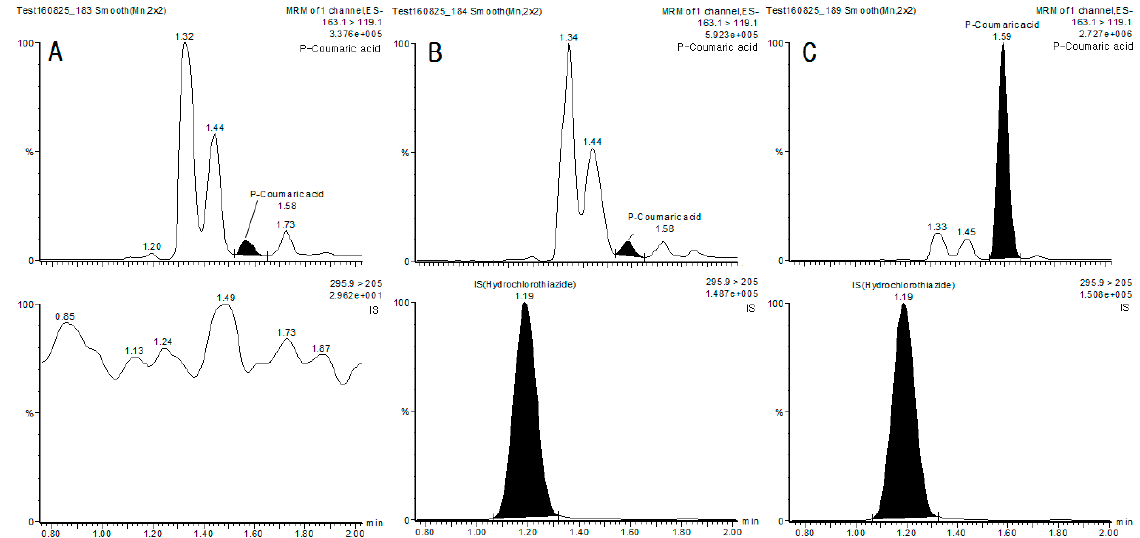
Figure 3. Representative Chromatogram of p -Coumaric acid ( top ) and internal standard ( bottom ) in human plasma. ( A ) Chromatogram profile of a blank plasma spiked with 500 µ g/mL internal standard, ( B ) Chromatogram profile of plasma sample spiked with p -CA 0.2 ng/mL (LLOQ) and 500 μ g/mL internal standard, ( C ) Chromatogram profile of plasma sample spiked with p -CA 20 ng/mL (ULOQ) and 500 μ g/mL internal standard.